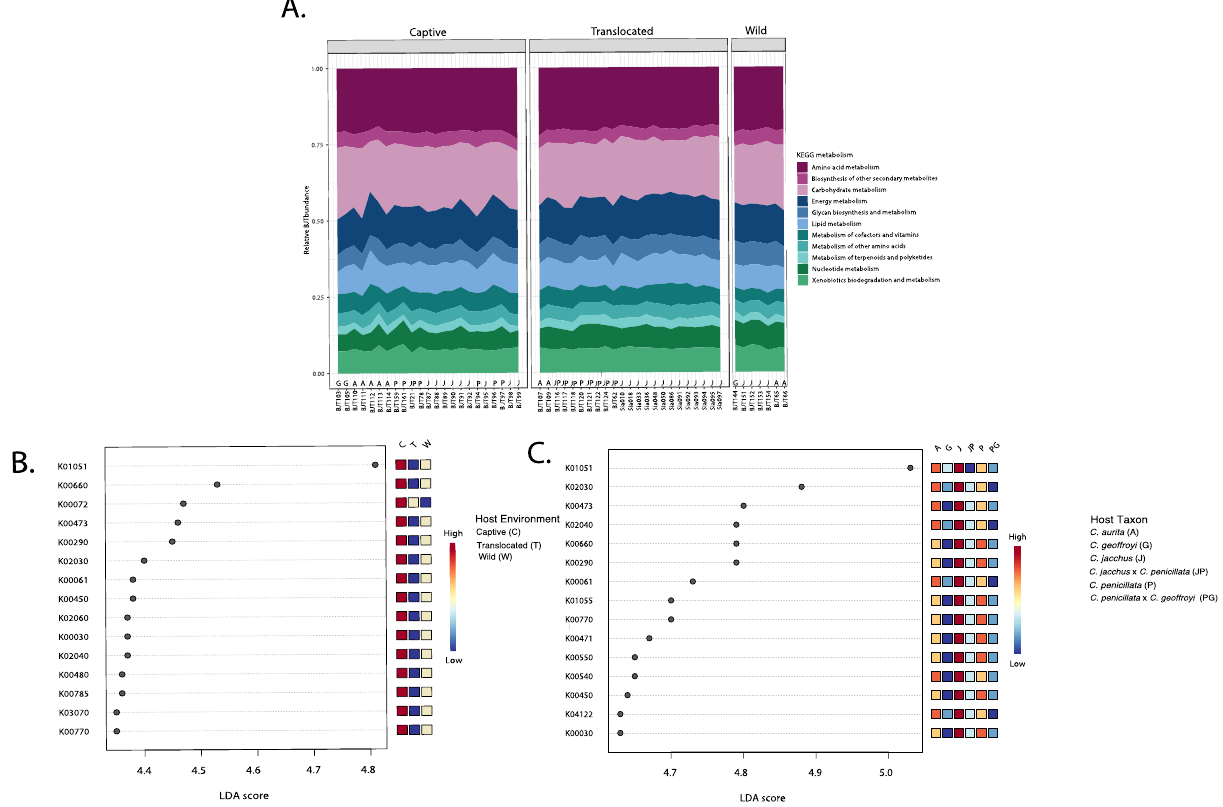
Figure 5. ( a ) Relative abundance of predicted KEGG pathways by host environment and taxon classification. ( b ) LefSe analysis of predicted KEGG pathway abundance by host environment. ( c ) LefSe analysis of predicted KEGG pathway abundance by host taxon. Legend of host classifications are shown to the right of each